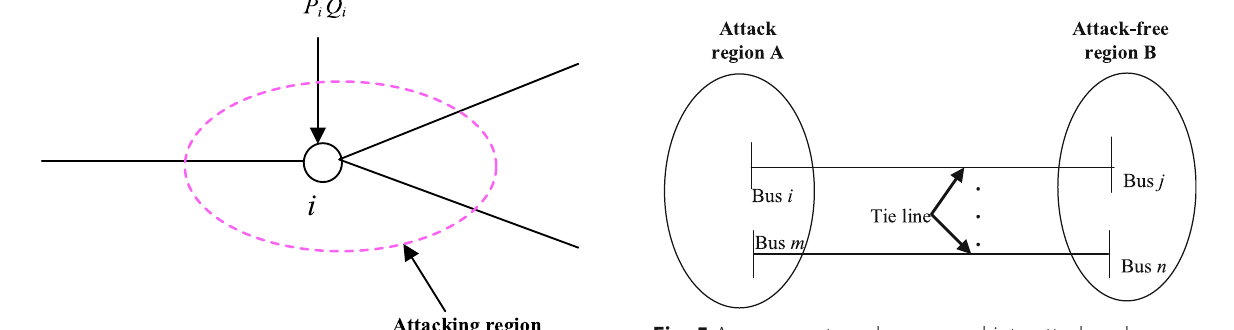
Fig. 5 A power system decomposed into attack and attack-free